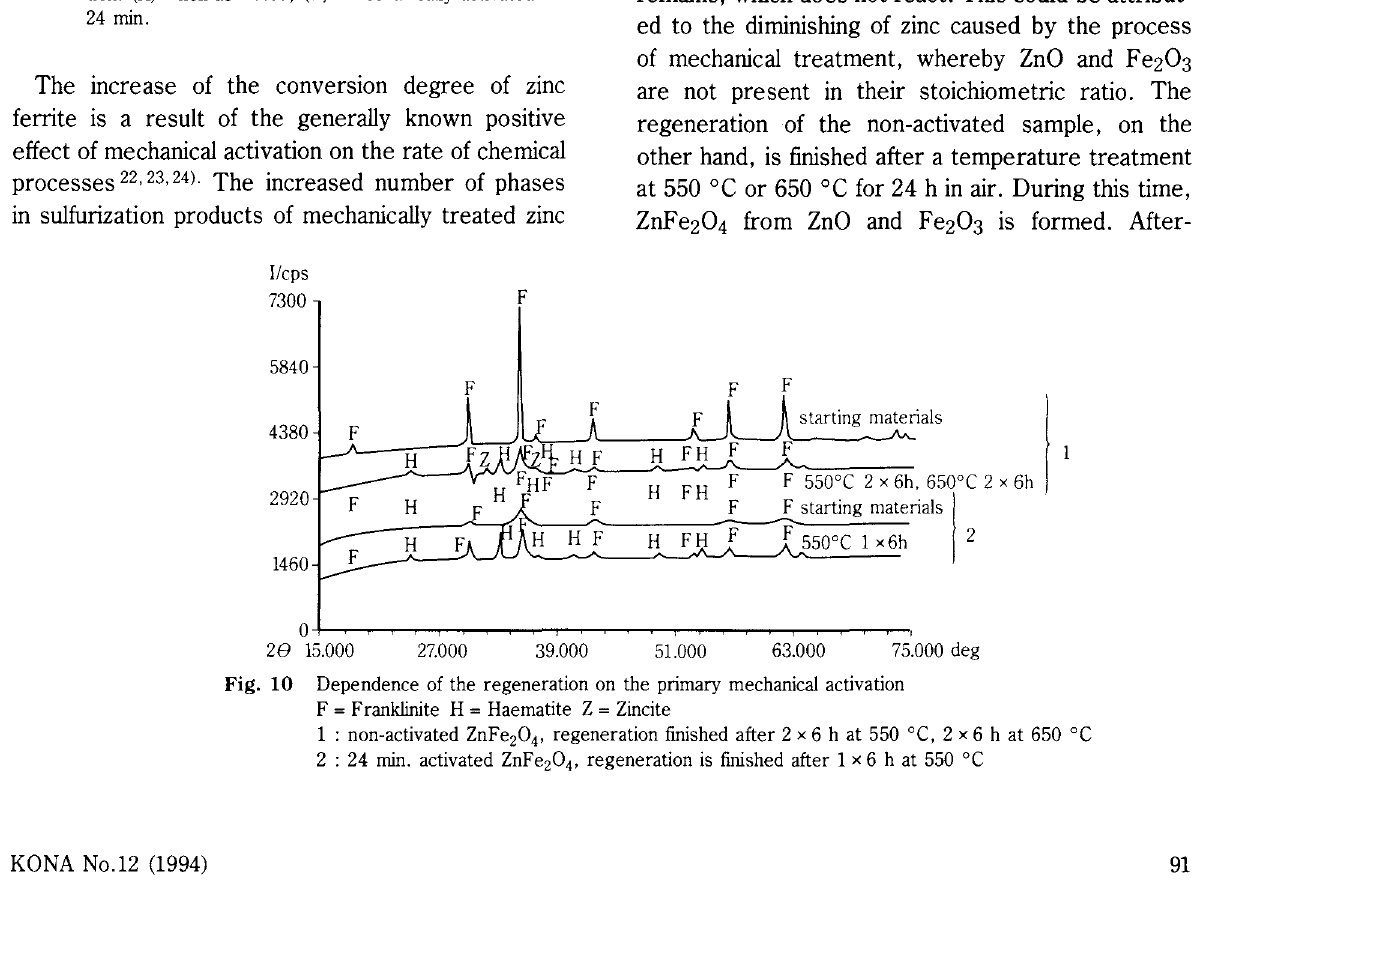
Fig. 9 Scanning electron micrograph of zinc ferrite after sulfuriza tion. (A)- non-activated, (B) -mechanically activated for 24 min.